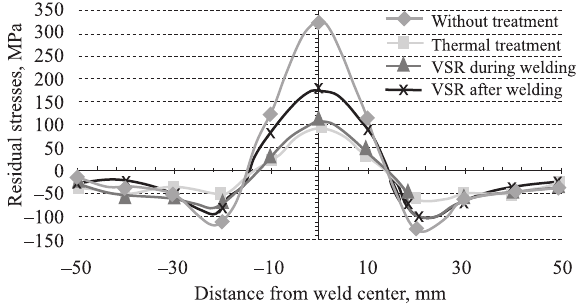
Fig. 1. Work-desk for vibratory